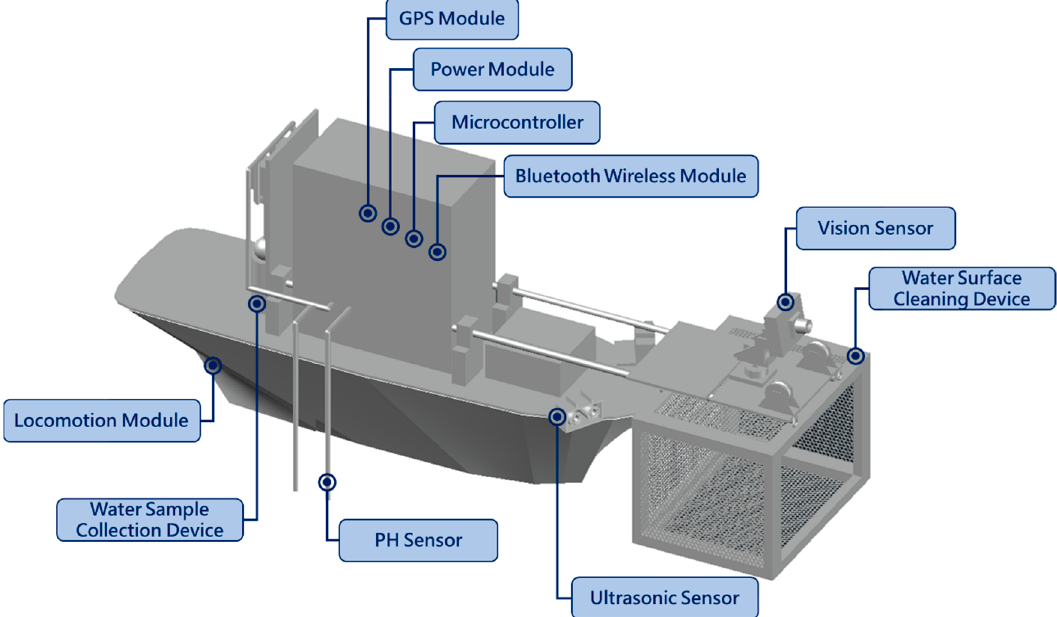
Figure 1. Overall view of the positions of all components inside the MF-USV.